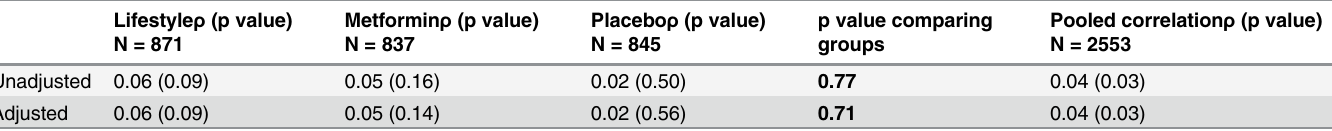
Table 3. Correlations of Changes in Adiponectin and Changes in Albumin/creatinine ration (ACR). Adiponectin concentrations were measured at baseline and at Year 1 of intervention. ACR was measured at baseline and at end-of-study. Values presented are Spearman ’ s correlation coefficient ρ (p value), except the column testing group differences in the correlation. Adjustments include age, race and